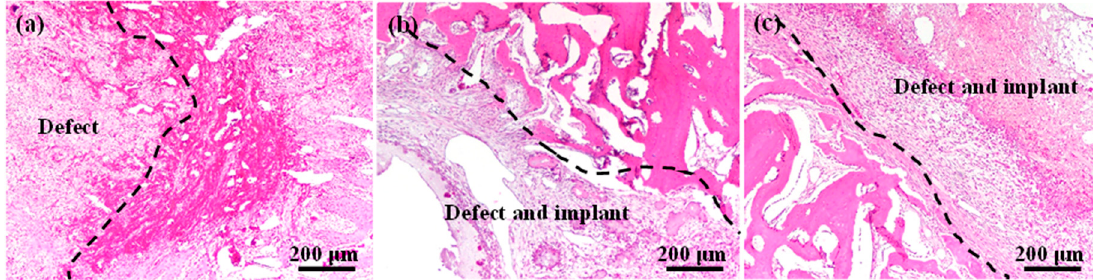
Figure 6. Images of hematoxylin and eosin (H&E)-stained bone tissue 2 weeks after implantation: ( a ) blank, ( b ) control , and ( c ) α -CSH samples.